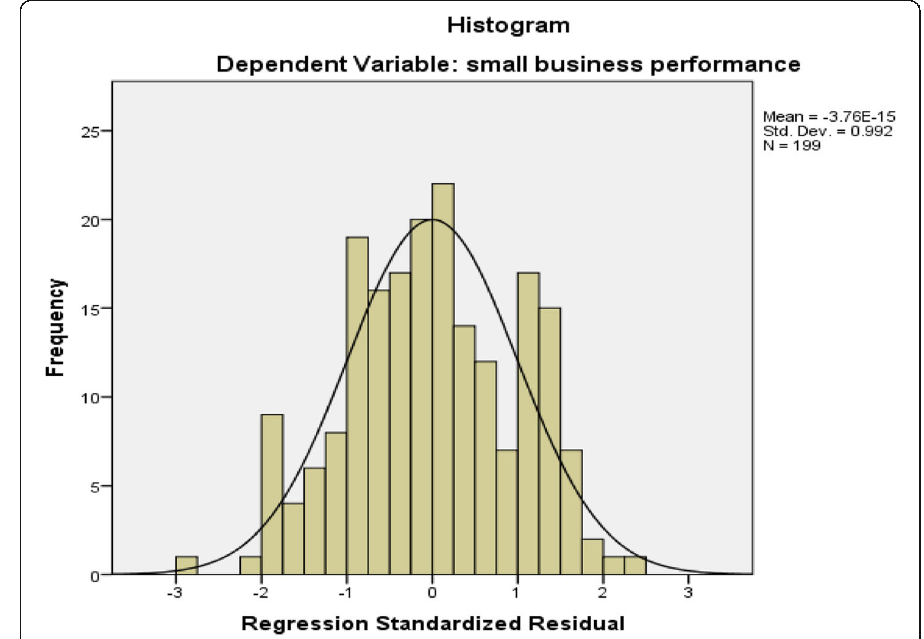
Fig. 2 Frequency and regression standardized residual